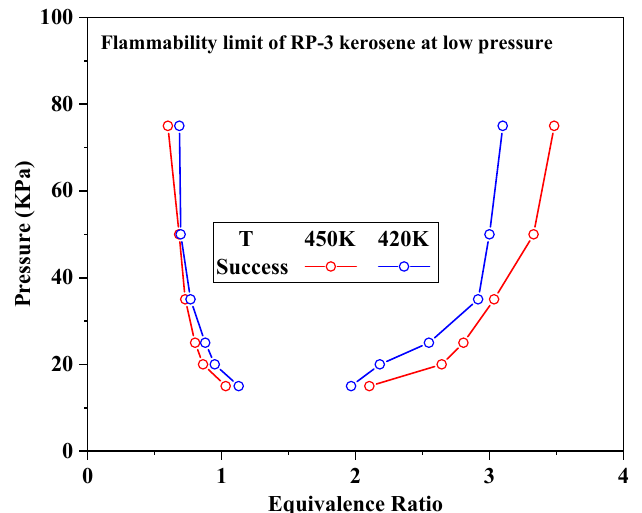
Figure 4. Flammability limit values for aviation kerosene at low pressures as functions of the equivalence ratio.